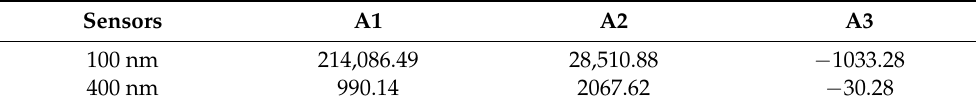
Table 3. The conversion parameters’ value for the 400 nm and 100 nm sensors. Sensors